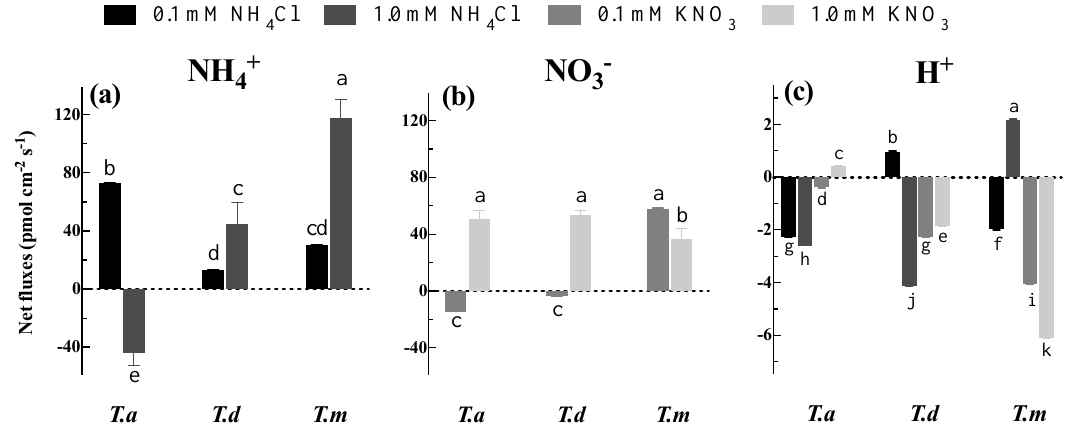
Figure 4. Net fluxes of NH 4+ ( a ), NO 3 − ( b ) and H + ( c ) under different concentrations of NH 4 Cl and KNO 3 . Bars indicate standard errors ( n = 8). Different letters indicate significant differences among the treatments according to Duncan’s Multiple Range Test at 5% level. T. a , T. d , and T. m represent T. ascendens , T. distichum and T. mucronatum , respectively.